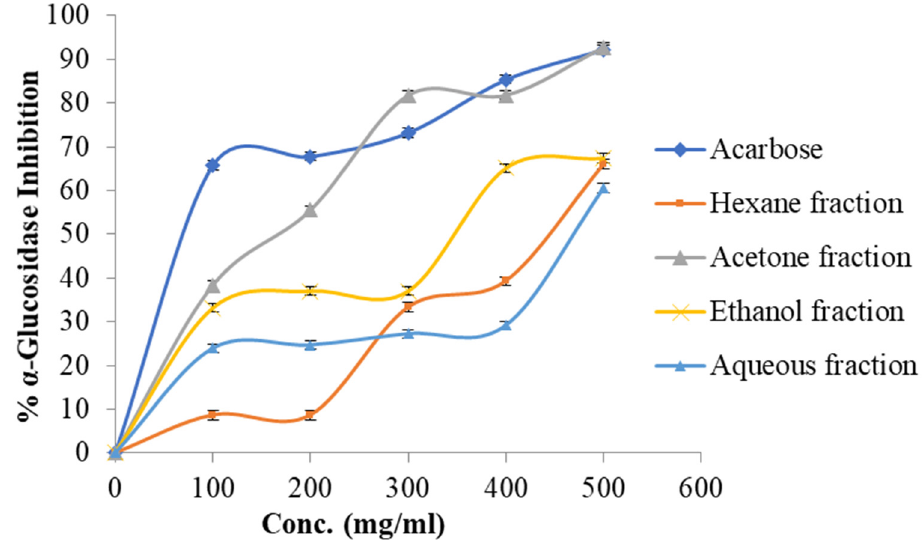
Figure 4. α -Glucosidase inhibitory effect by Artemisia scoparia four extracts and Acarbose. Values are the mean ± SD of triplicate experiments ( p -value < 0.05).